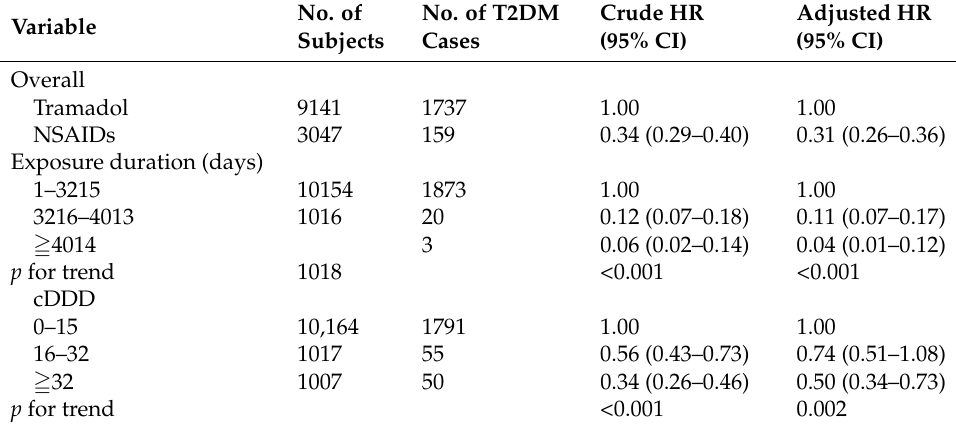
Table 2. Association between administration of non-steroidal anti-inflammatory drugs (NSAIDs) and risk of type 2 diabetes mellitus